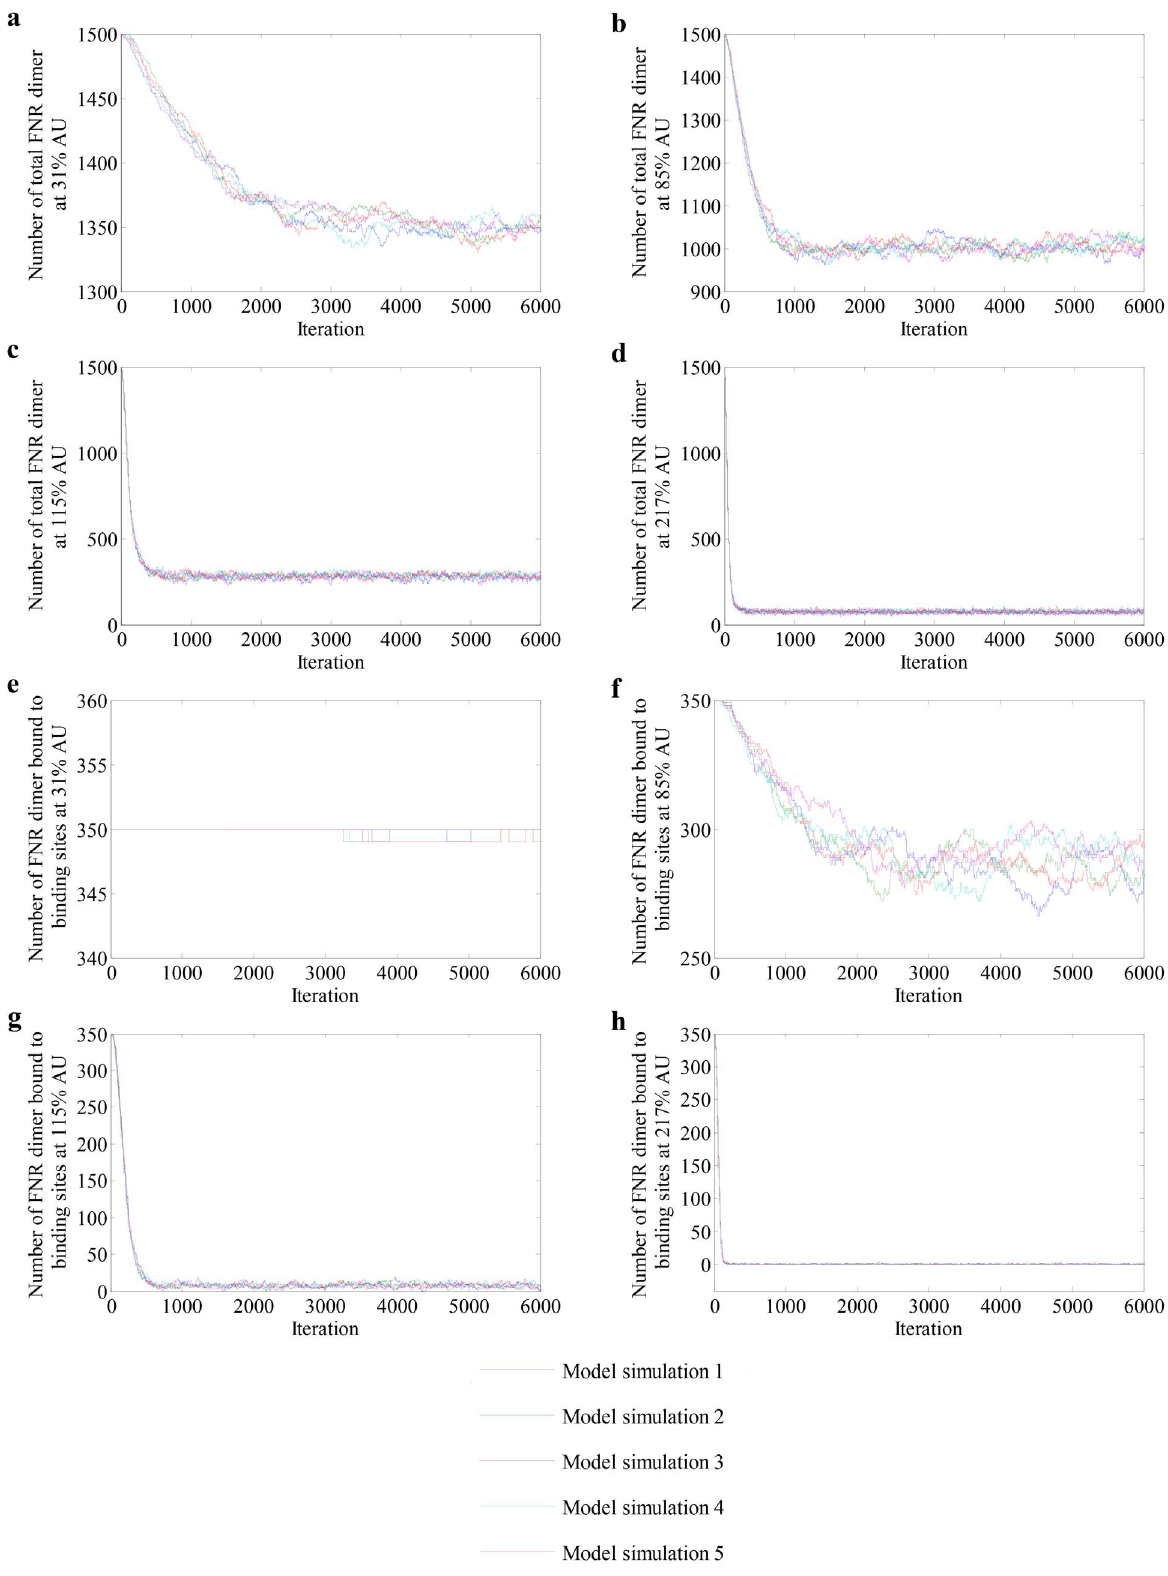
Figure 5. Profiles of FNR dimers at different AU levels. (a–d) Variation of the numbers of total FNR dimers and (e–h) numbers of FNR dimers bound to DNA at AU levels 31%, 85%, 115% and 217% respectively.